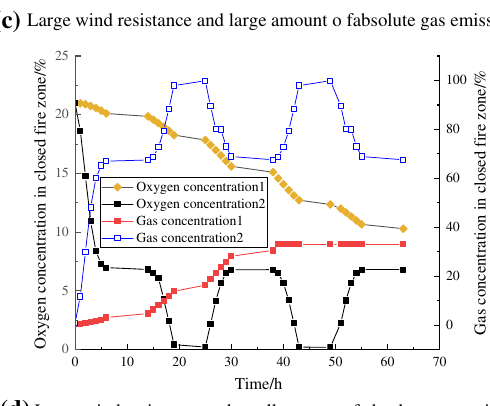
(d) Large wind resistance and small amount of absolute gas emission Fig. 16 Scissor and fork analysis method for gas and oxygen